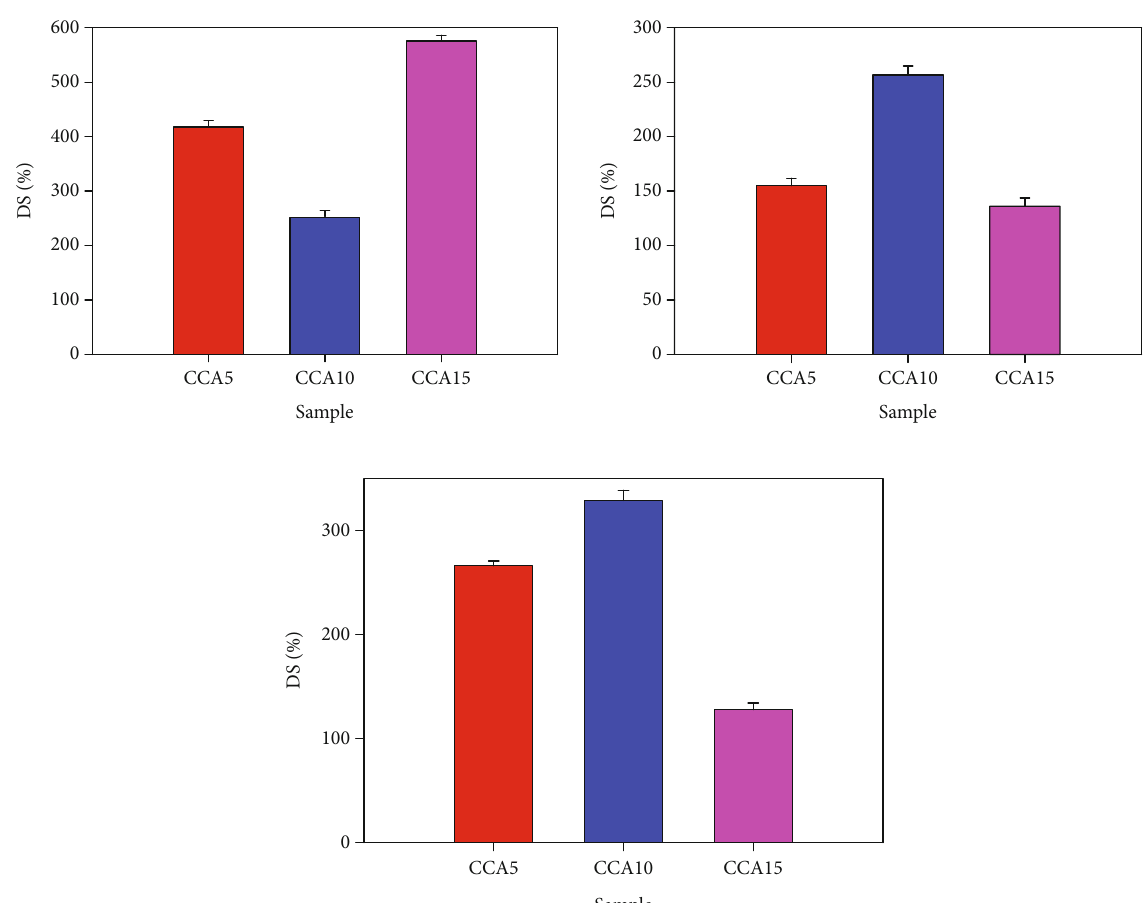
Figure 4: DS of CCA biocomposite fi lms in distilled water and in pH 2.0 and pH 7.4